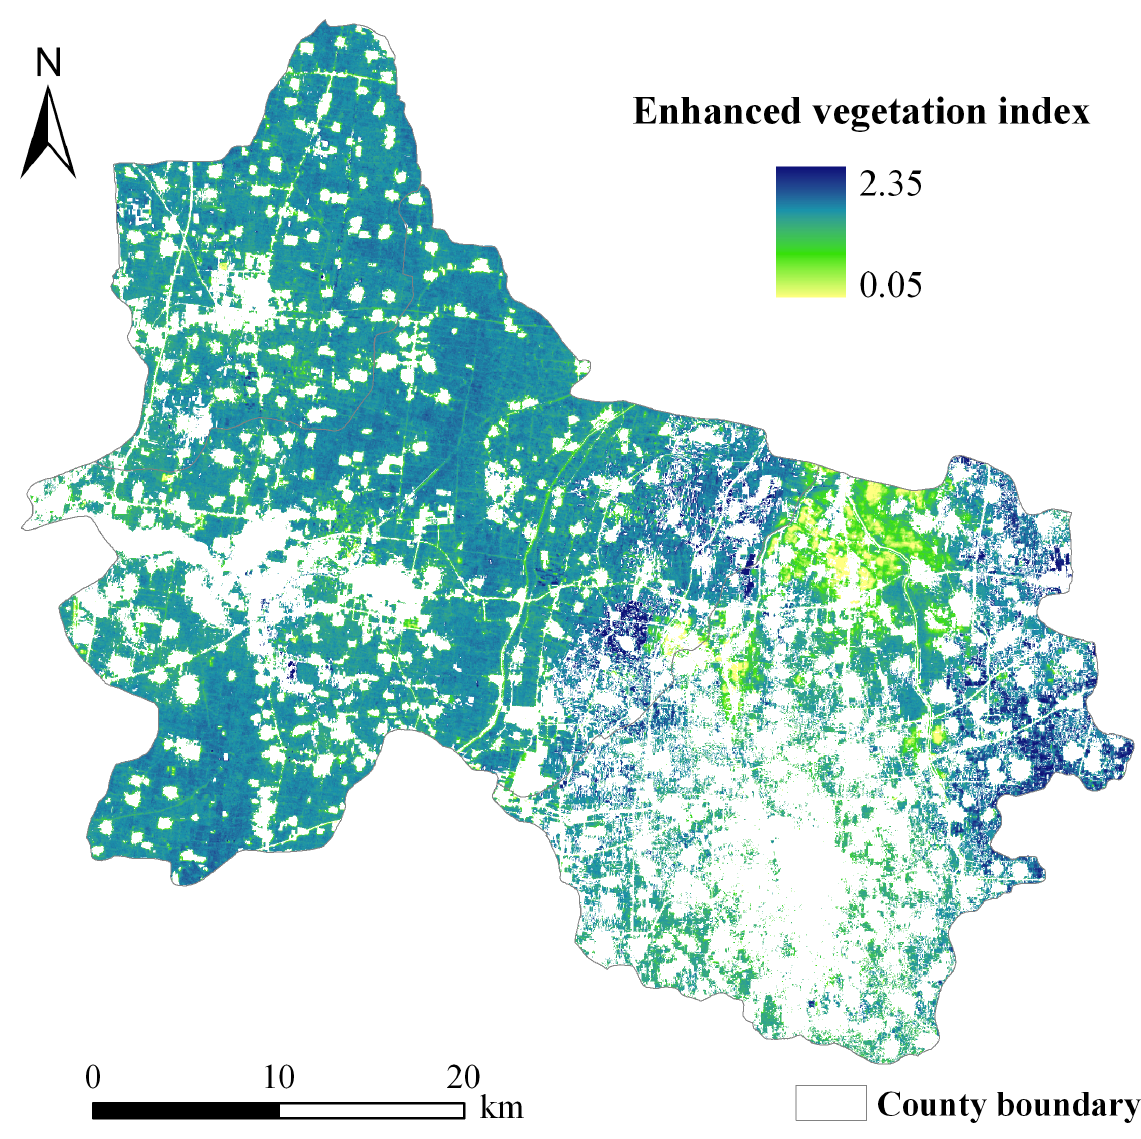
Figure 5. Spatial distribution map of enhanced vegetation index in maize fields in three counties in North China.